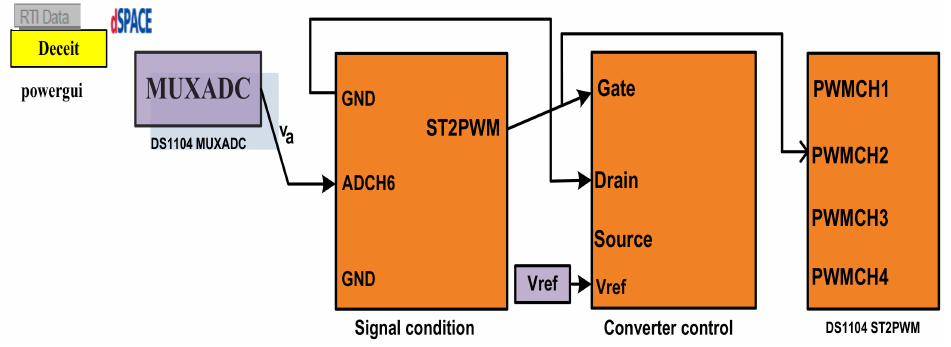
Figure 8. Real-time converter control hardware process via dSPACE.